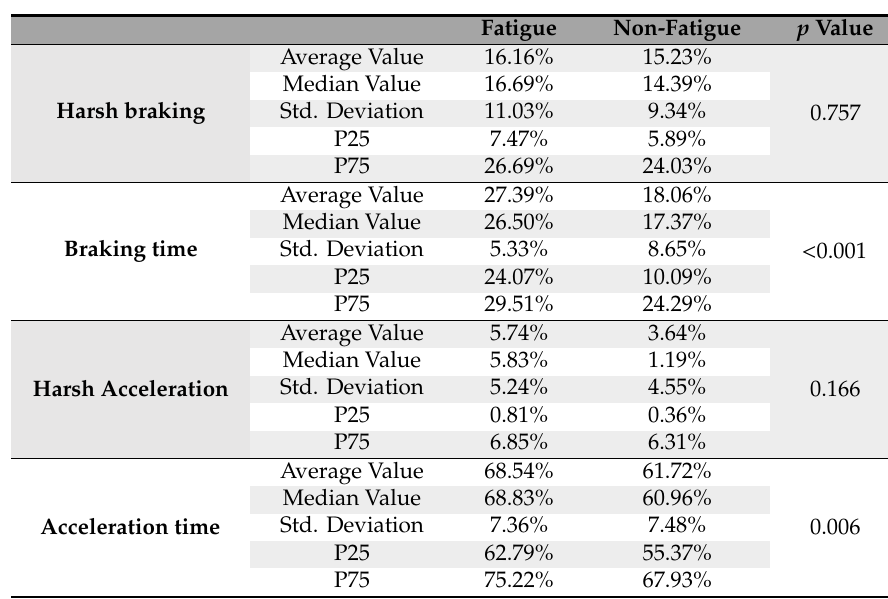
Table 11. Driving behavior grouped by level of